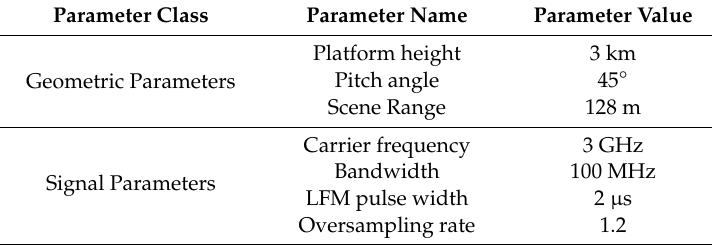
Table 1. Main parameters for range profile imaging